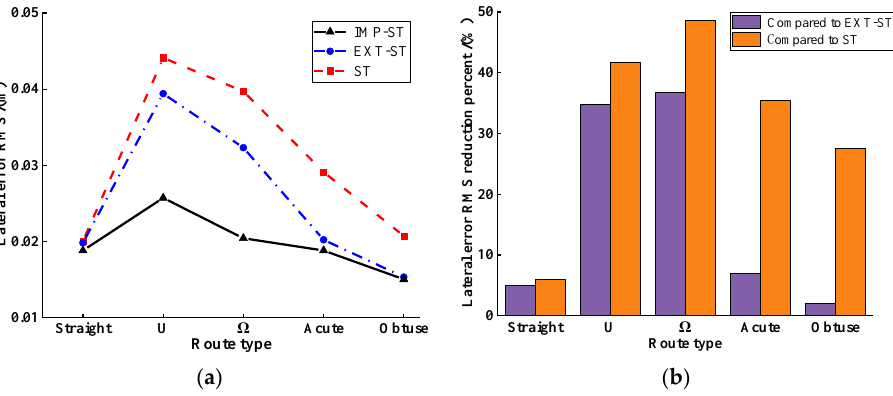
Figure 13. Path tracking performance comparison and analysis. ( a ) lateral error RMS; ( b ) lateral error RMS reduction percent.